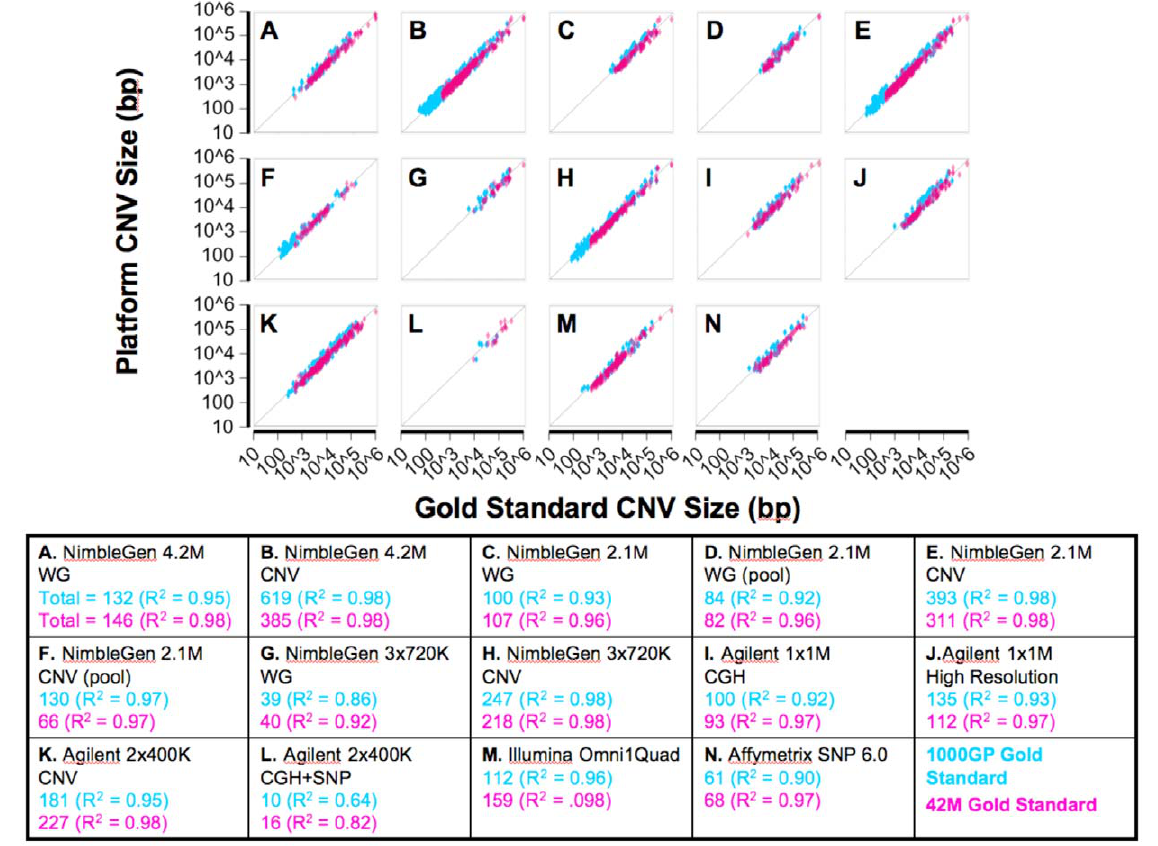
Figure 3. Overall, the greatest absolute number of GS CNVs